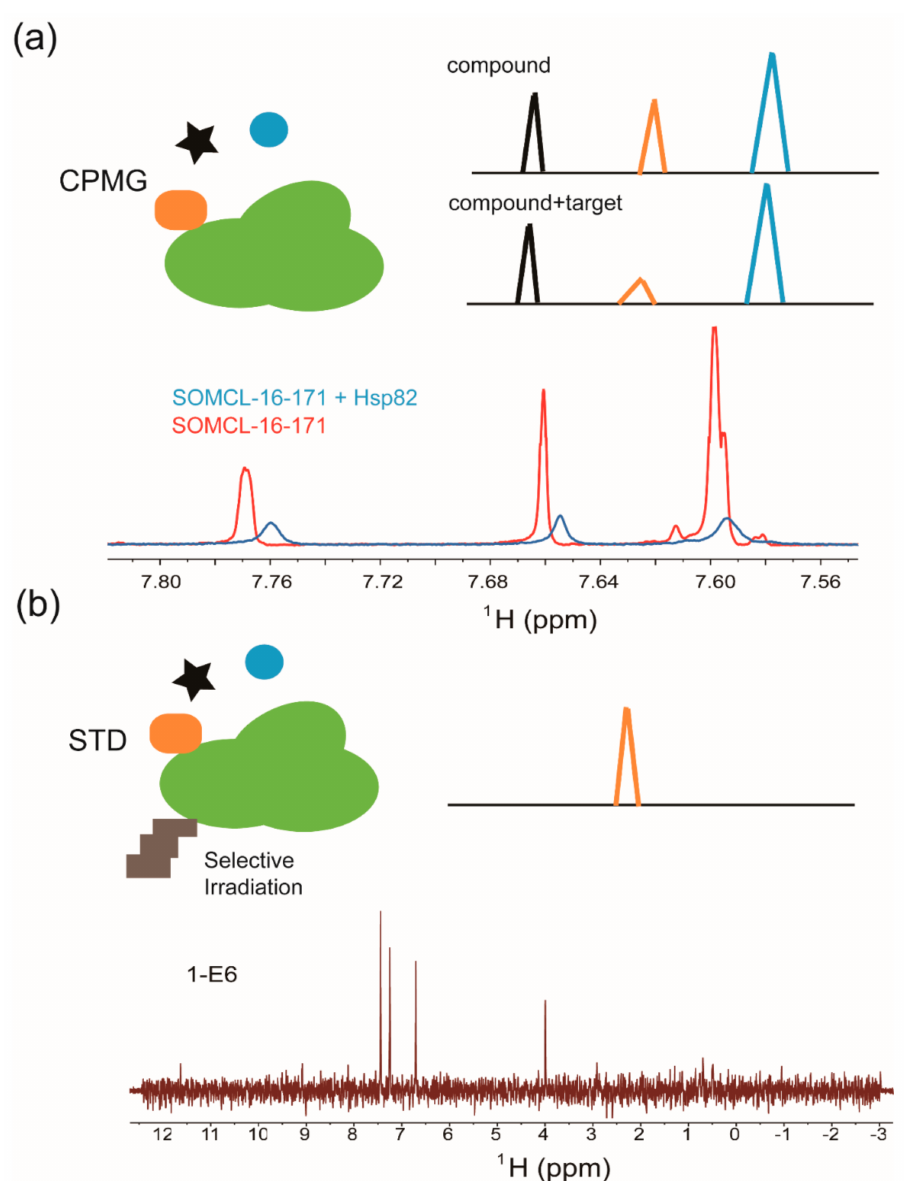
Figure 2. Ligand-observed NMR in hit compound screening and/or validation: ( a ) Cartoon il- lustration of the Carr-Purcell-Meiboom-Gill pulse sequence (CPMG) experiment. Validation of Hsp82:SOMCL-16-171 interaction by using the CPMG technique is shown as an example. ( b ) Car- toon illustration of the difference spectrum in the saturation transfer difference (STD)